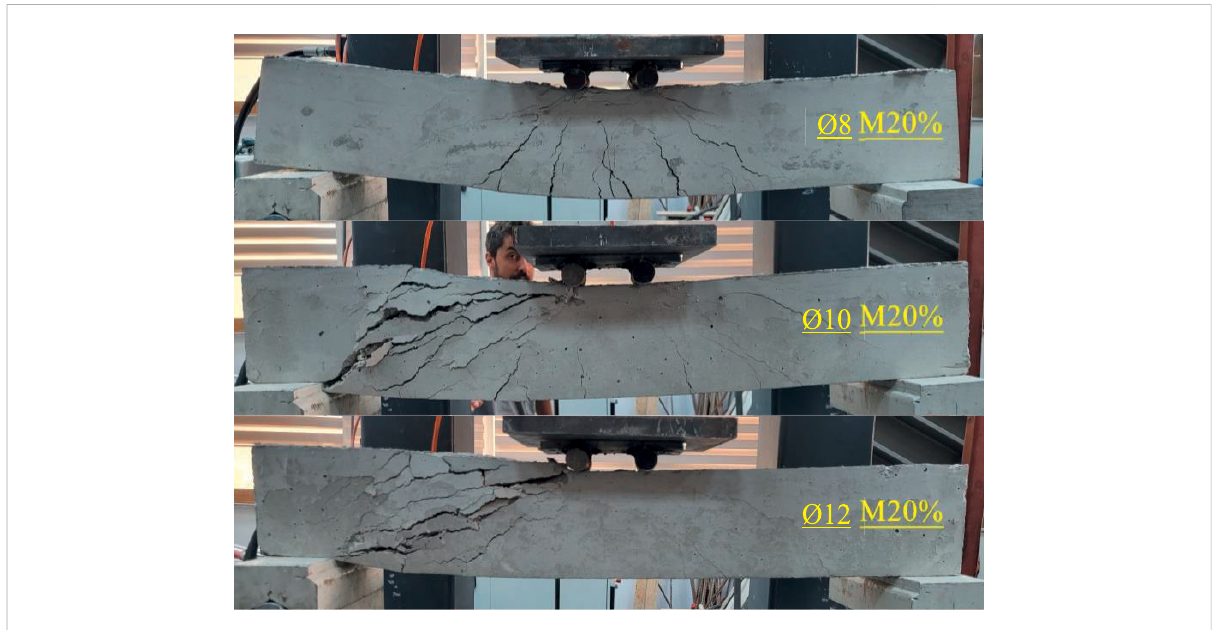
Fracture and bending attitude of RCB for V 8-M20%, V 10-M20%, V